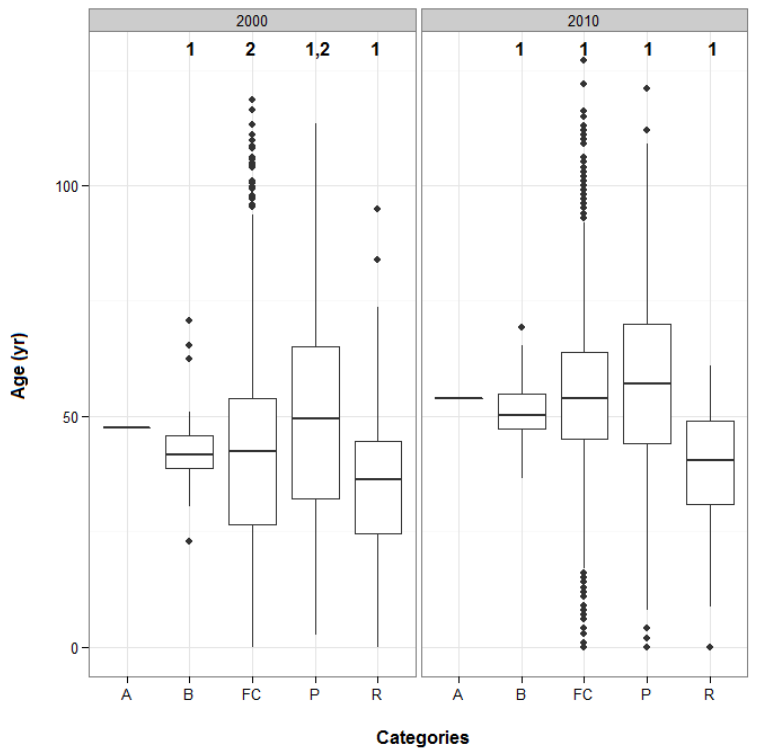
Figure 3. Boxplots of the mean age (in years) of the stands per A: entire study area, B: buffer zones around sites selected for restoration, FC: forest company owned land, P: protected areas, R: sites selected for restoration. Equal numbers displayed above bars denote significance between categories ( p ≤ 0.050).